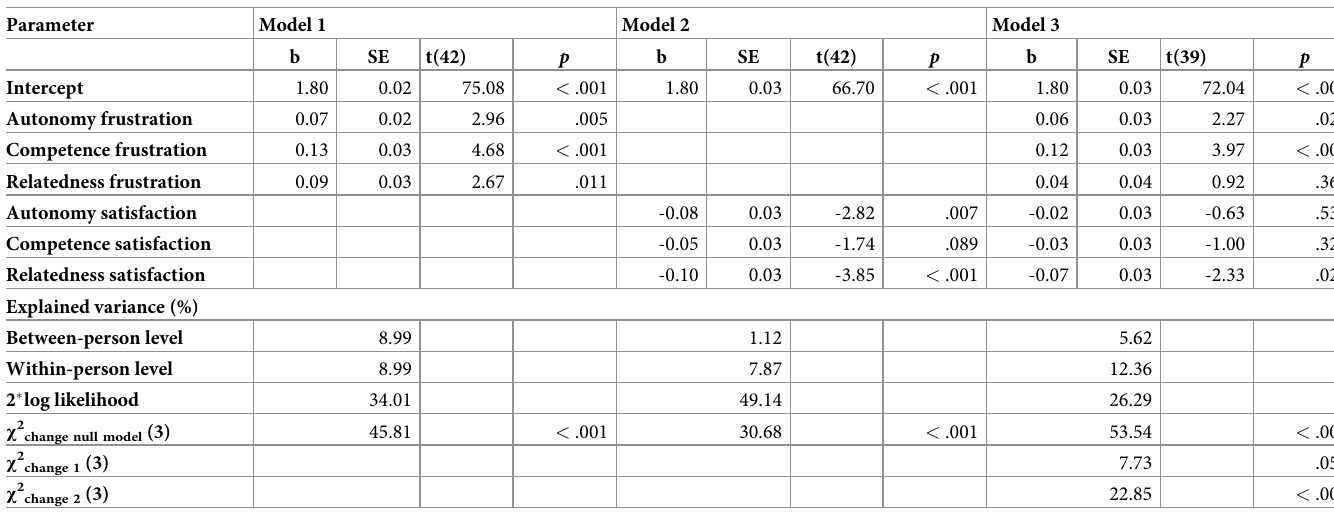
Table 2. Summary of the model estimates for psychological